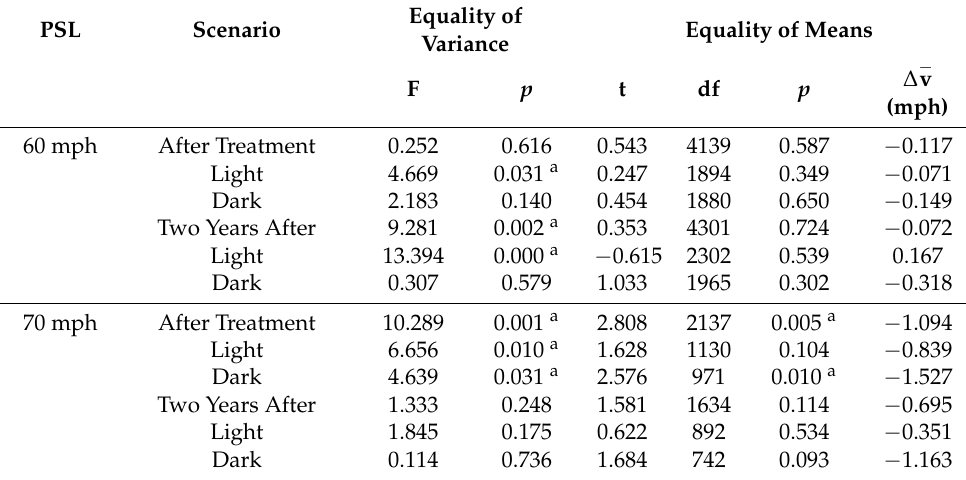
Table 2. Change in mean speed by posted speed limit.